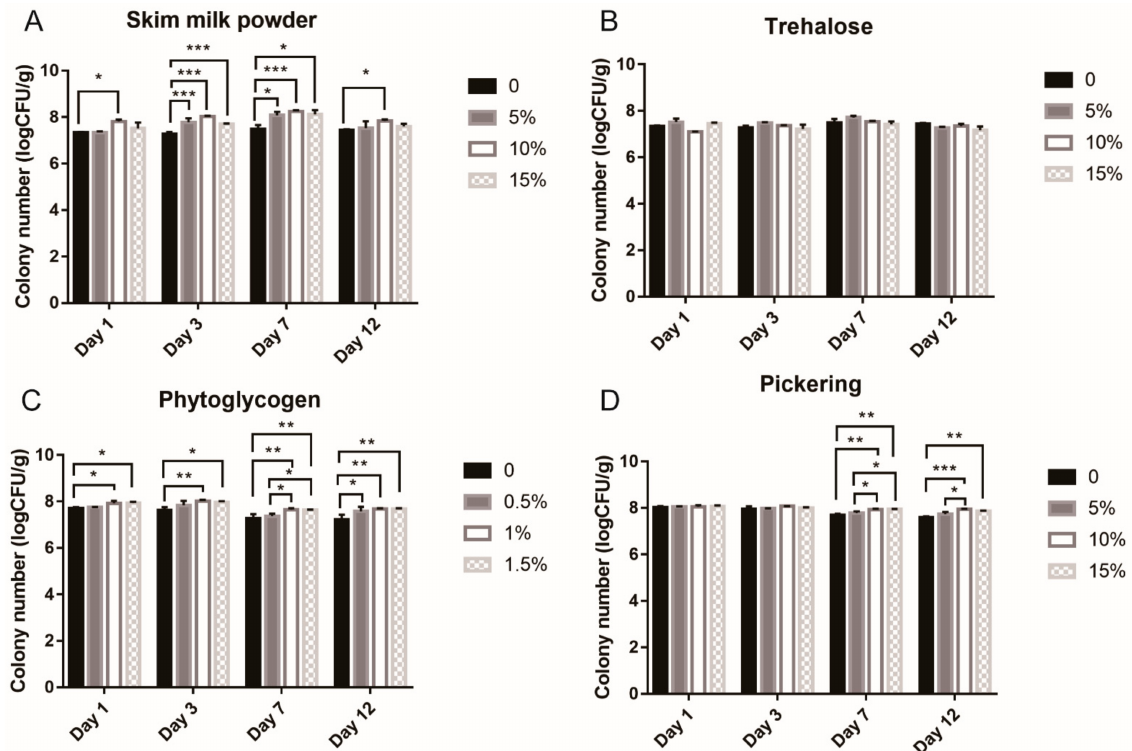
Figure 3. Viability of free and encapsulated L. casei K17 on feed during storage at 4 ◦ C for 12 days. ( A ) Viability of L. casei K17 formulated with 5%, 10% and 15% ( w / w ) of skim milk powder. ( B ) Viability of L. casei K17 formulated with 5%, 10% and 15% ( w / w ) of trehalose. ( C ) Viability of L. casei K17 formulated with 0.5%, 1% and 1.5% ( w / w ) of water-soluble phytoglycogen nanoparticle and 10% ( w / w ) of skim milk powder. ( D ) Viability of L. casei K17 formulated with 5%, 10% and 15% ( w / w ) of Pickering emulsions, 10% ( w / w ) of skim milk powder and 1% water-soluble phytoglycogen nanoparticle. Values (mean ± SE, n = 3), * p < 0.05, ** p < 0.01, *** p <